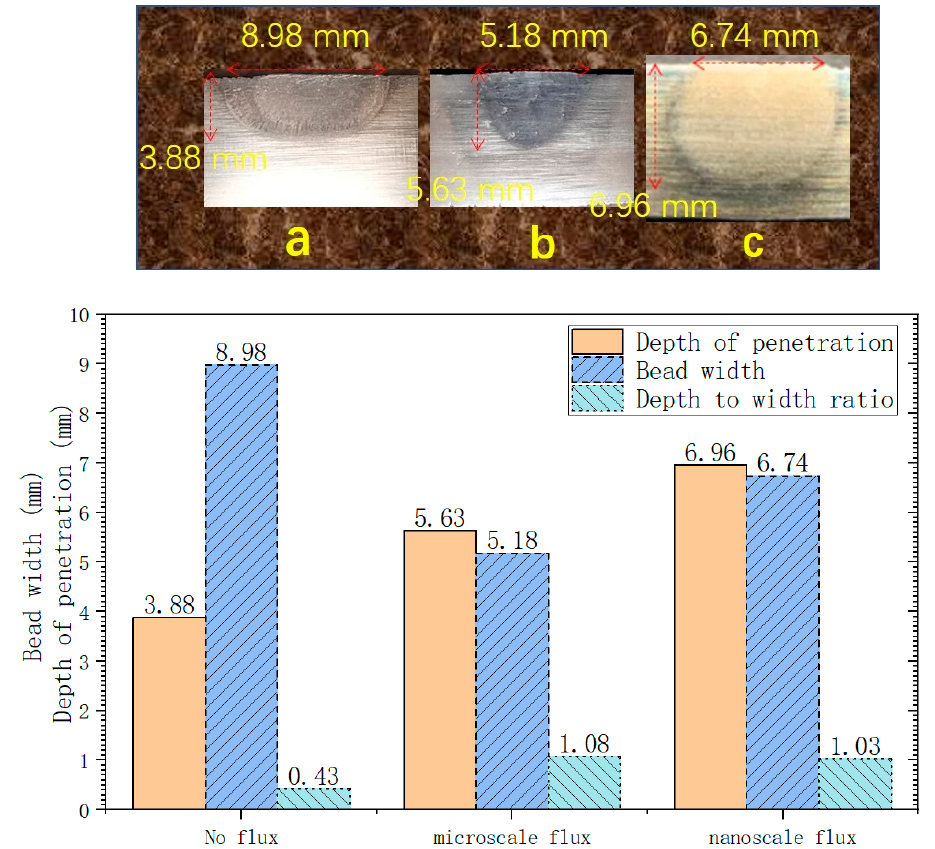
Figure 6. Top: weld bead geometry photo of welded joints without fluxes ( a ), with Fe 2 O 3 microscale ( b ) and Fe 2 O 3 nanowire fluxes ( c ), welding speed of 60 mm/s. Below: weld bead geometry variation on different concentration fluxes ( d / w ratio).